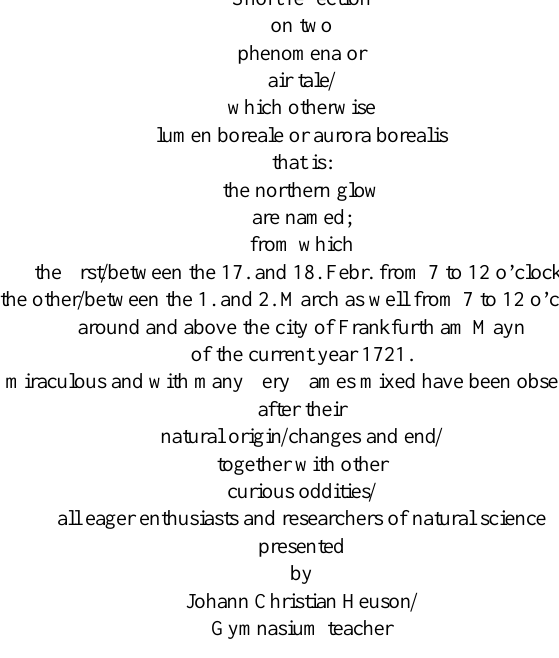
Figure 1. Title page of Heuson’s first booklet. Translated: